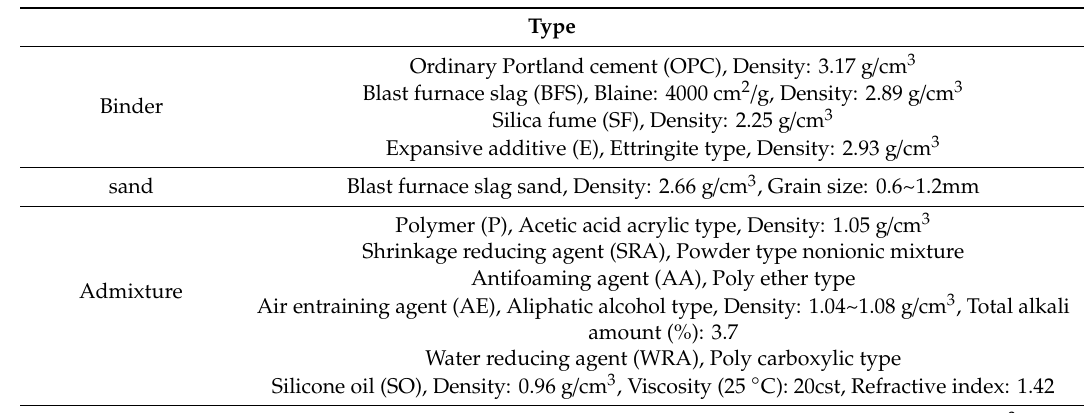
Table 1. The materials